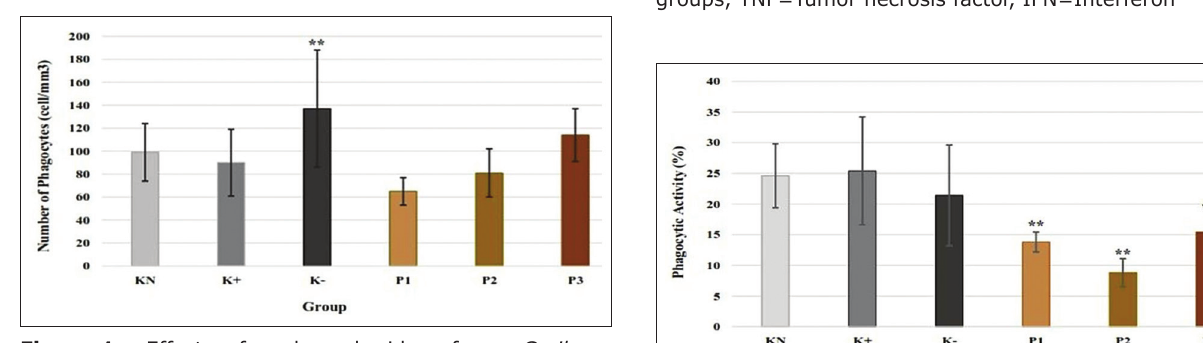
Figure-1: Effect of polysaccharides from Caribena versicolor on a number of phagocytes (cell×10 5 /mm 3 ). KN=Normal control, K+=Positive control, K−=Negative control, P1=Administration of polysaccharides (PS) before infection, P2=Administration of PS after infection, P3=Administration of PS before and after infection. Values are represented as means±standard deviation (n=6). **p<0.05 compared to KN group.